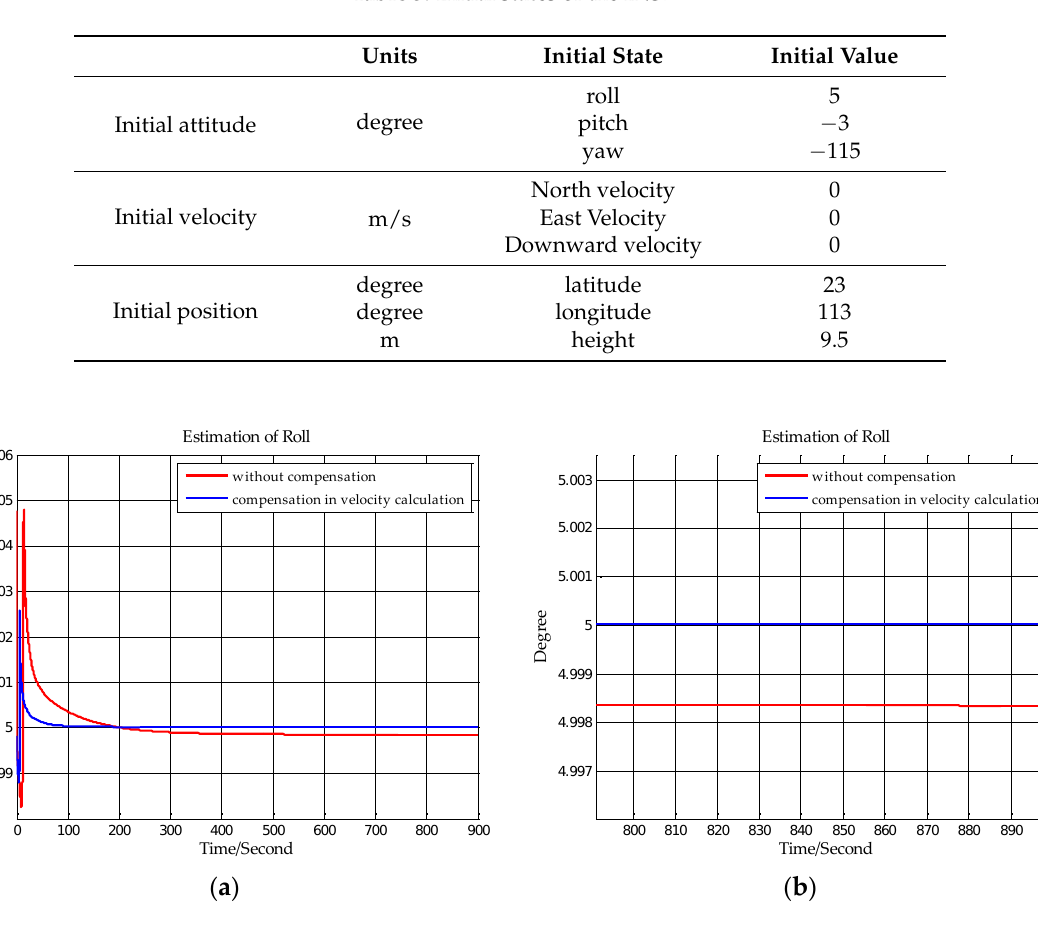
Figure 7. ( a ) is the estimation of roll with compensation in velocity calculation, and ( b ) is the enlarged view of ( a ) in the last 100 s.